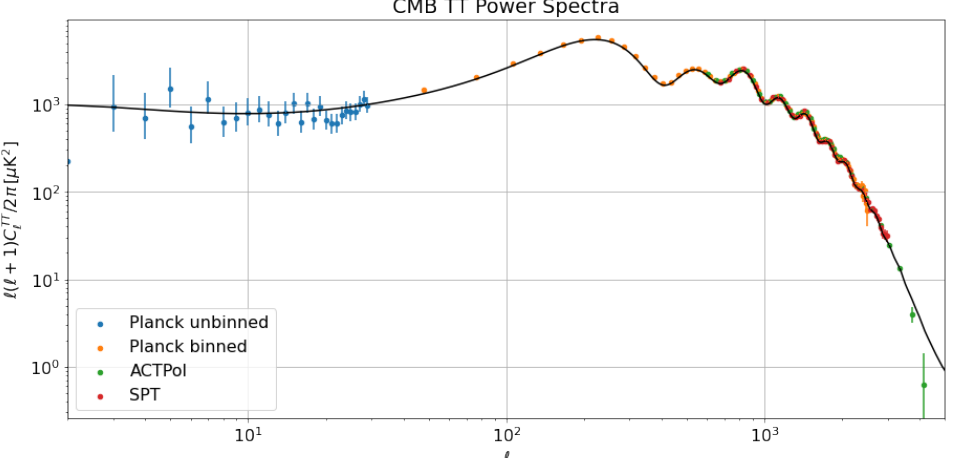
Figure 2. CMB anisotropies power spectrum. Data were obtained from the ACTPol, Planck and SPT experiments. At low multipoles l and large angular scales, Planck data have been left unbinned (not averaged over the multipoles l ), whereas at large multipoles l and small angular scales, the data have been binned (averaged) over ∆ l = 30. Data credit: NASA/LAMBDA Science